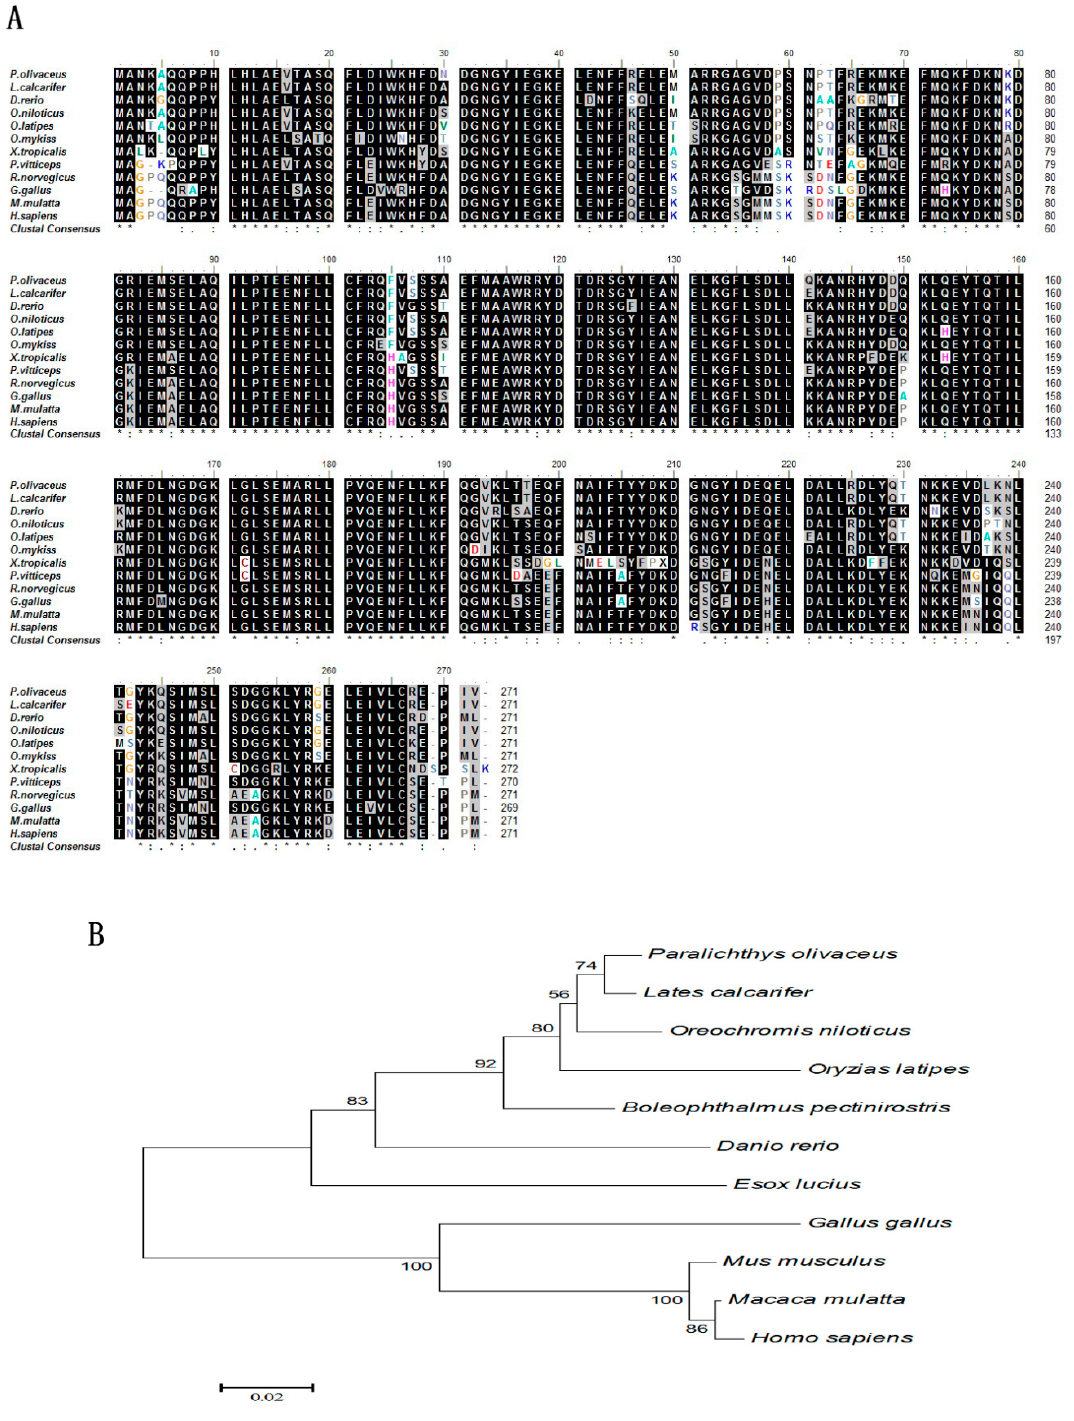
Figure 3. Molecular phylogenetic analysis of CALB2. ( A ) Amino acid sequence alignment of the P. olivaceus CALB2 with that of other species (light black blocks show identical amino acid residues for the sequences shown); ( B ) phylogenetic tree of the P. olivaceus CALB2 relative to the homologues from other vertebrates (bootstrap values are shown at the branch